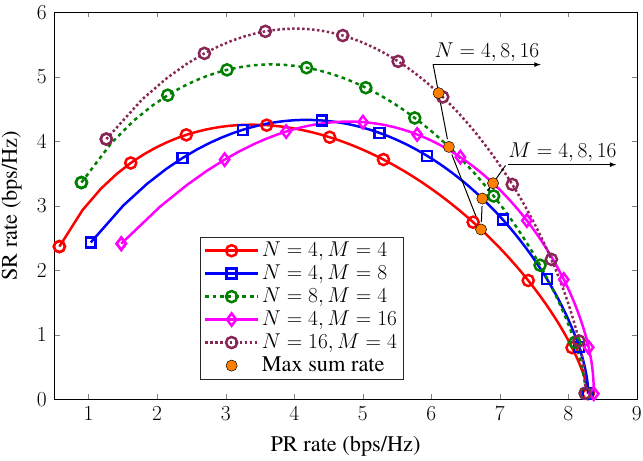
Figure 5. Trade-off between SR and PR